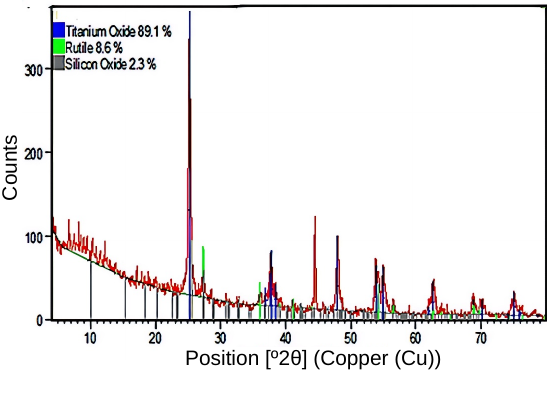
Figure 4: X-Ray Diffraction of TiO 2